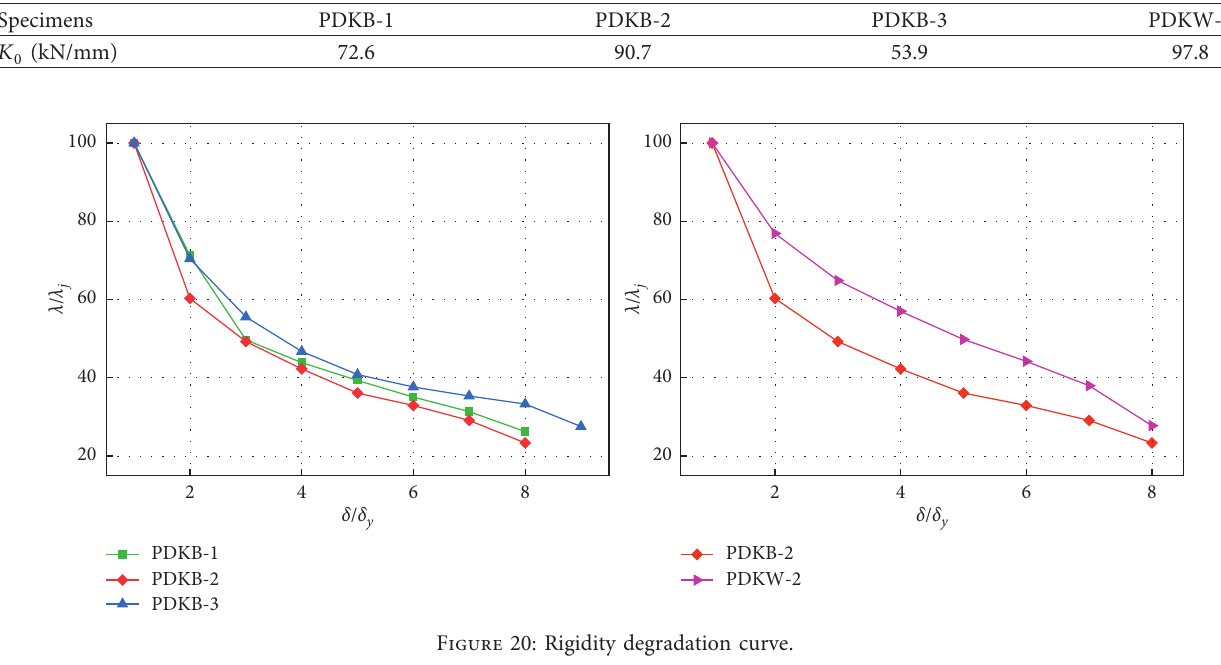
Table 11: Rigidity degradation coefficients of specimens.